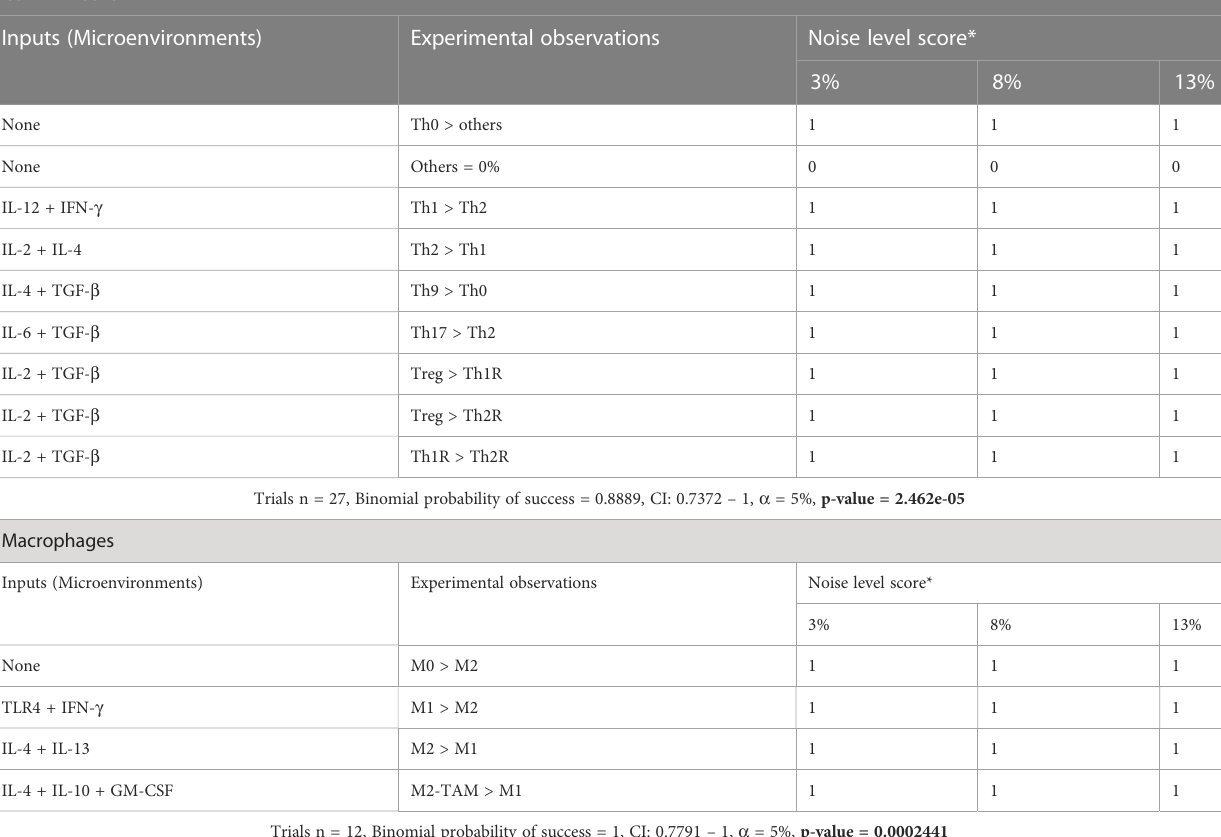
TABLE 1 Qualitative validation of stochastic models of the VAT cells. CD4+ T